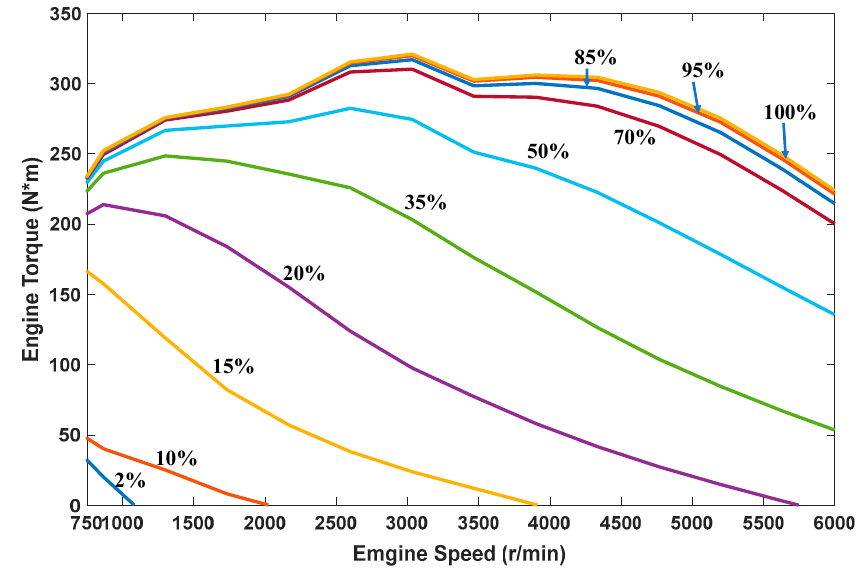
Figure 6. The partial load characteristic curve of the engine. Table 1. The amended rules of the target speed adjustment coefficient. The Opening of Electronic Throttle